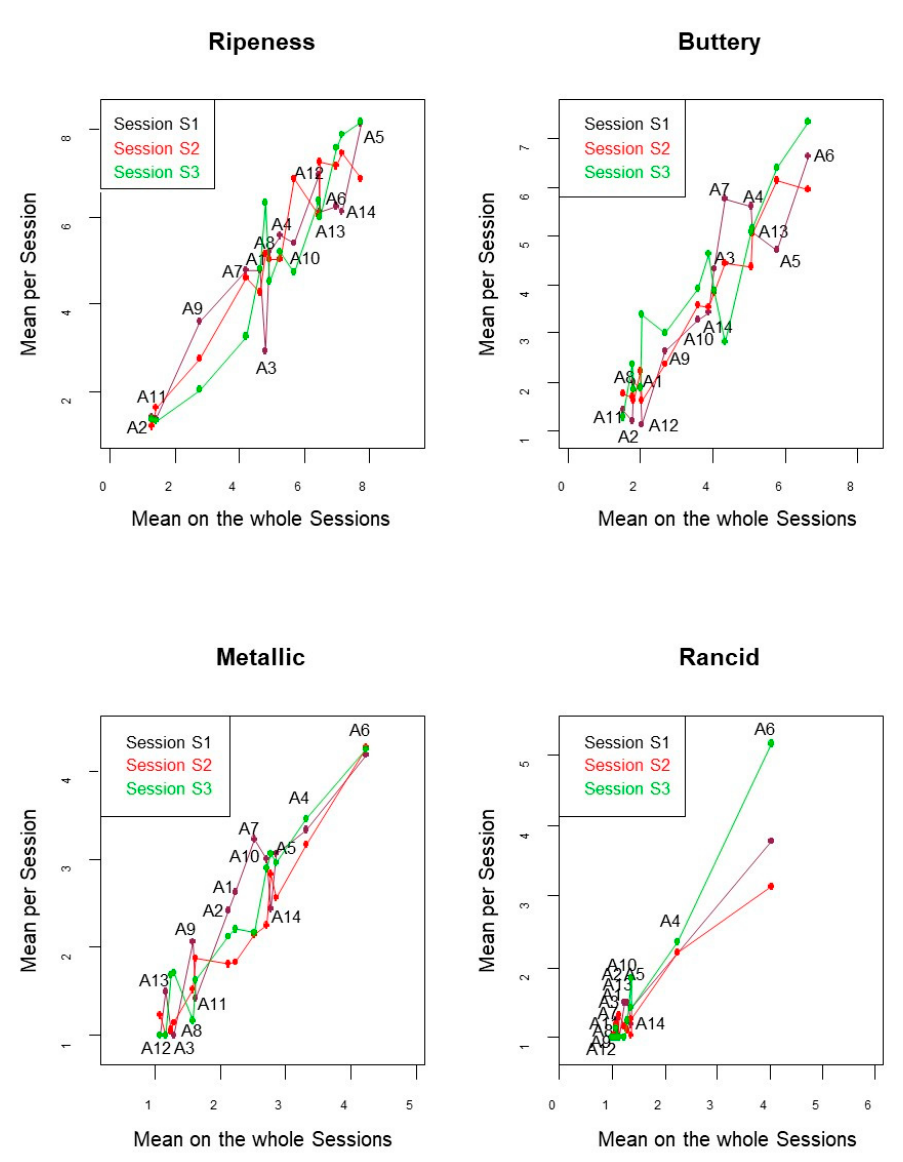
Figure 5. Panel performance. Panelist-session interaction. Means per session according to panelists over means of the whole sessions for selected descriptors (ripeness, buttery, metallic, and rancid).